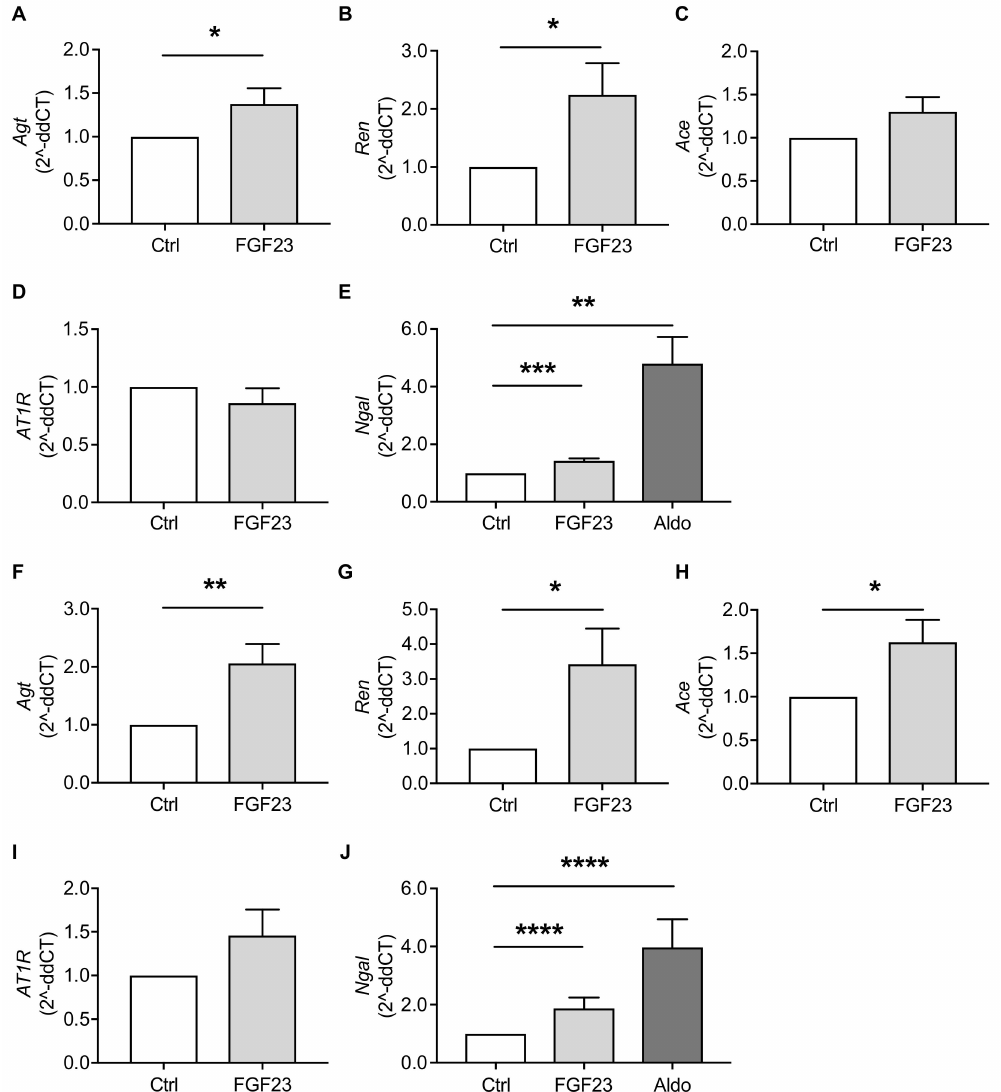
Figure 3. FGF23 induces RAAS-associated genes in neonatal rat ventricular myocytes (NRVM) and cardiac fibroblasts (NRCF) in vitro as shown by quantitative real-time PCR. ( A–D ) In NRVM, FGF23 treatment increases the mRNA expression of angiotensinogen ( Agt ) and renin ( Ren ), whereas the e ff ects of FGF23 on angiotensin converting enzyme ( Ace ) and angiotensin II receptor type 1 ( AT1R ) expression levels are not statistically significant. ( E ) FGF23 and aldosterone (Aldo) induce the mRNA